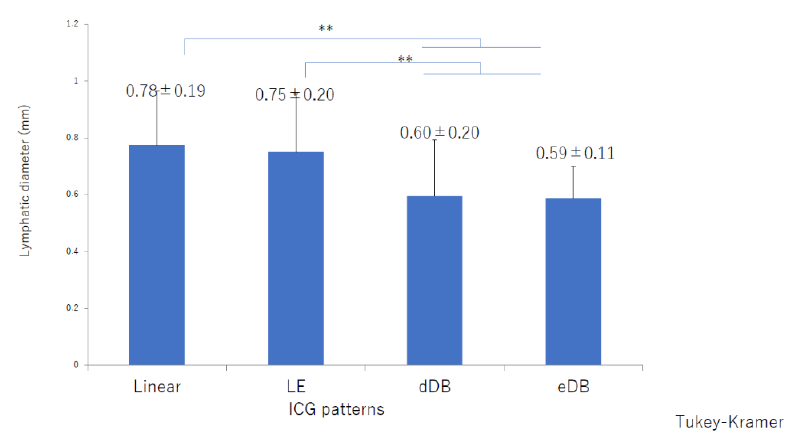
Figure 2. Lymphatic diameters by indocyanine green pattern in the ≥65 group. There was a significant decrease in lymphatic diameter with progression from the linear, LE, dDB through to the eDB pattern. dDB, distal dermal backflow; eDB, extended dermal backflow; LE, low enhancement; LEL, lower extremity lymphedema ** p < 0.01 (Tukey–Kramer test).